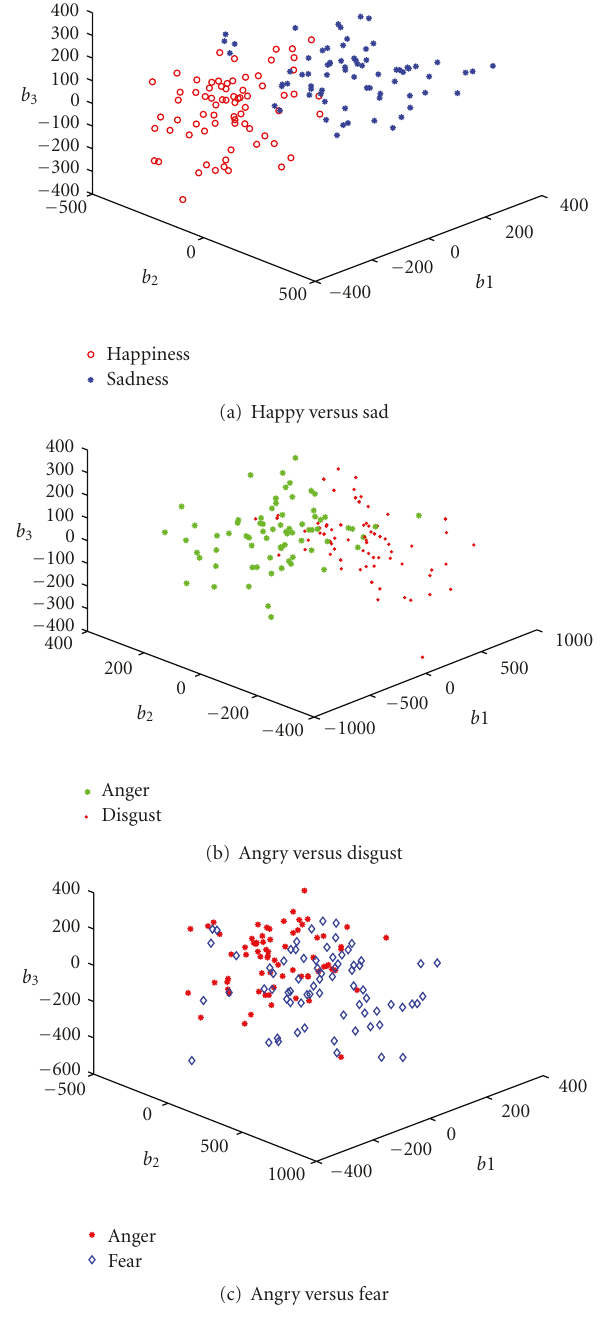
Figure 9: Separability of the facial expressions in the feature space of first three principal components of the SSV built from the full facial